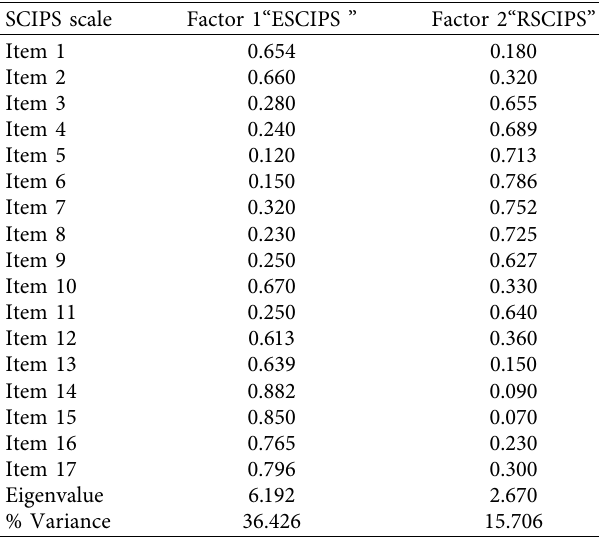
Table 2: Internal consistency of the SCIPS ( n � 275). Range Minimum Maximum Mean ± SD Cronb.a SCIPS